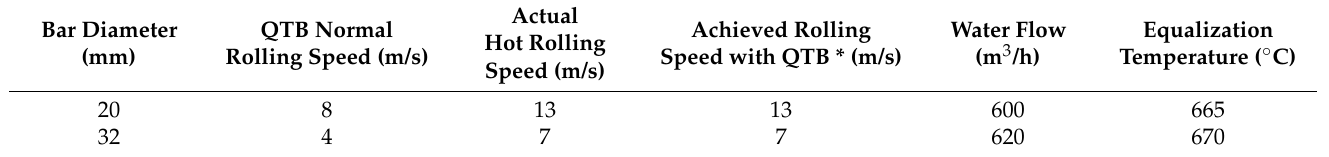
Table 2. Typical operation parameters for the QTB rebars